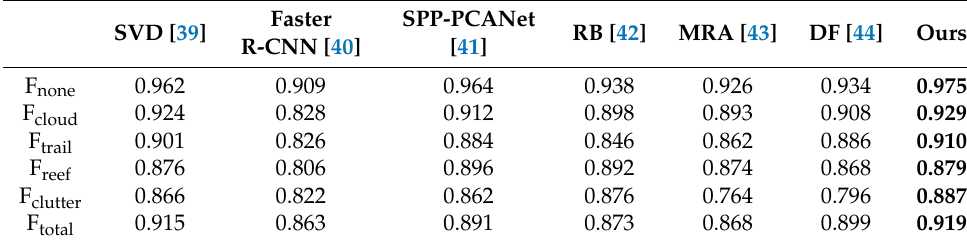
Table 4. F-score comparison results of the different algorithms. Faster SPP-PCANet RB [42] MRA [43] DF [44] SVD [39] R-CNN [40] [41]